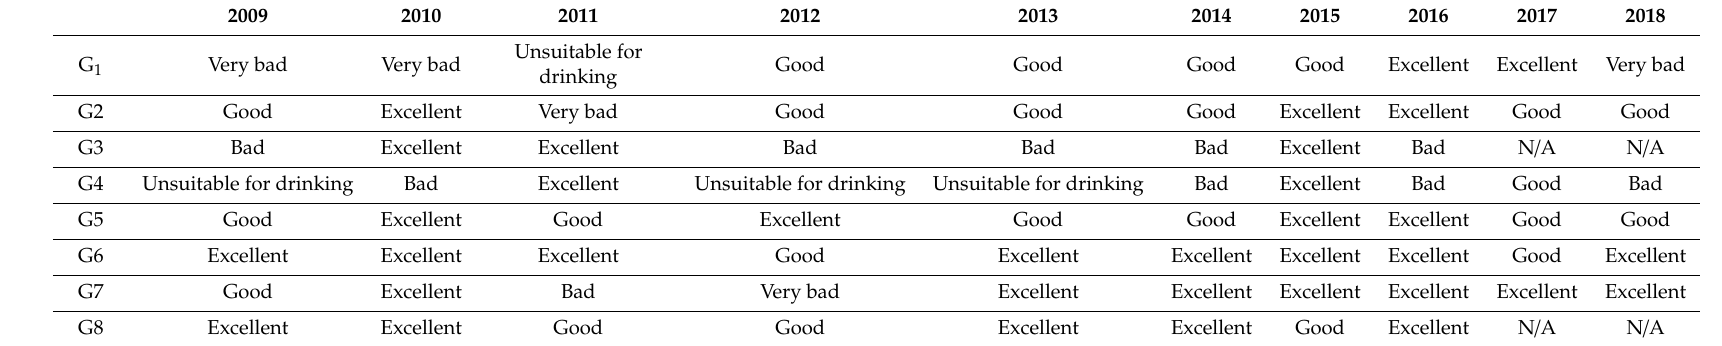
Table A3. Annual Groundwater classification based on WQI in the dry season.